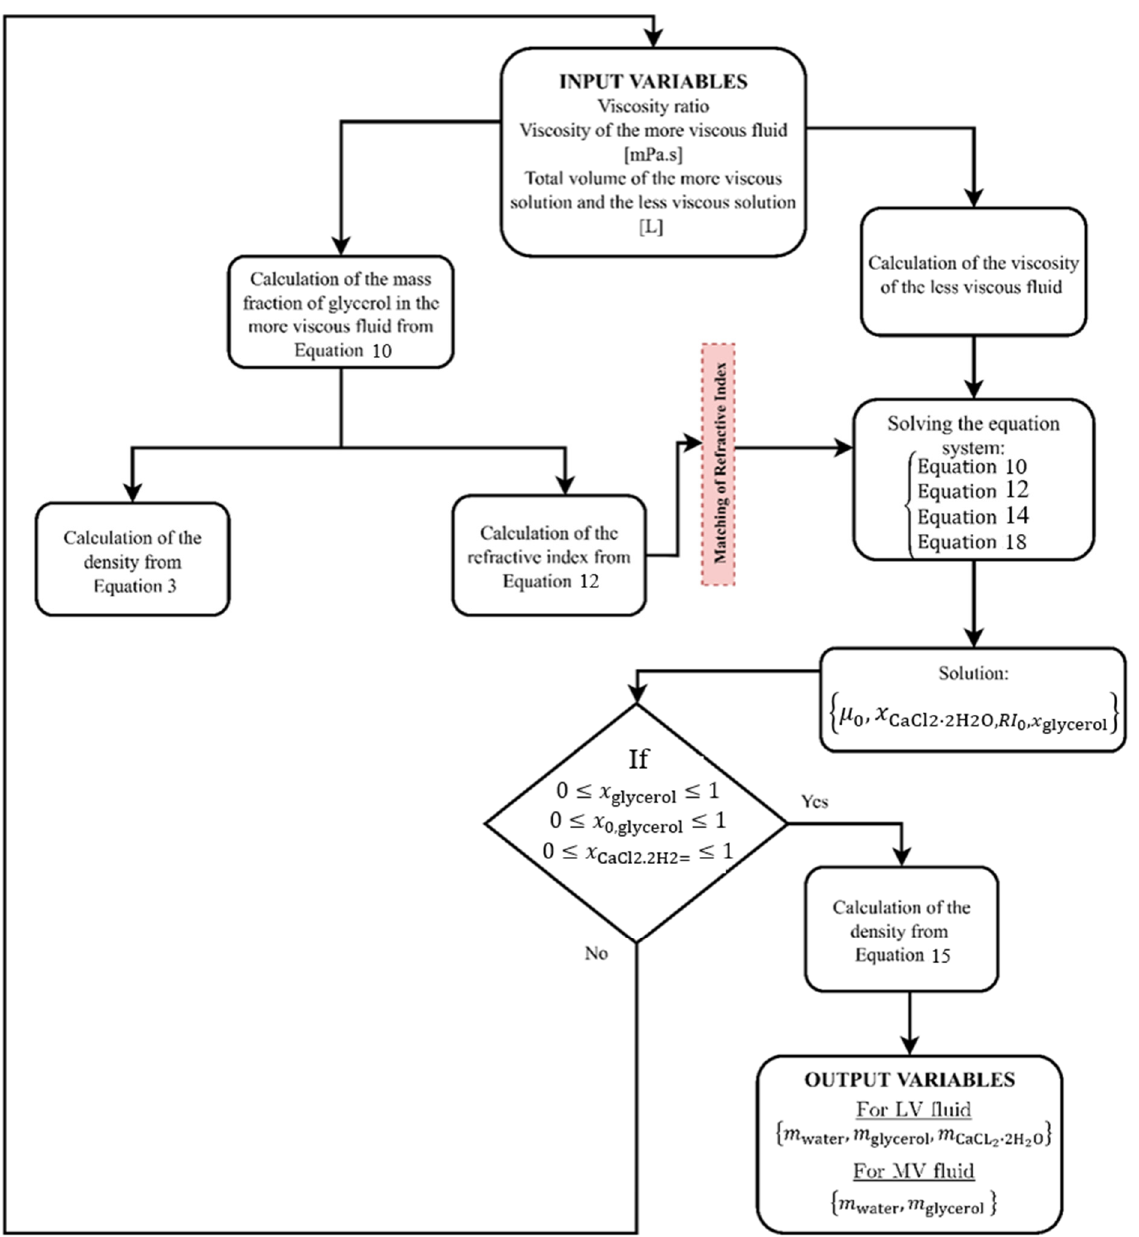
Figure 11. Flowchart for the design of two fluids with different viscosities for multiphase flow studies using PLIF technique.